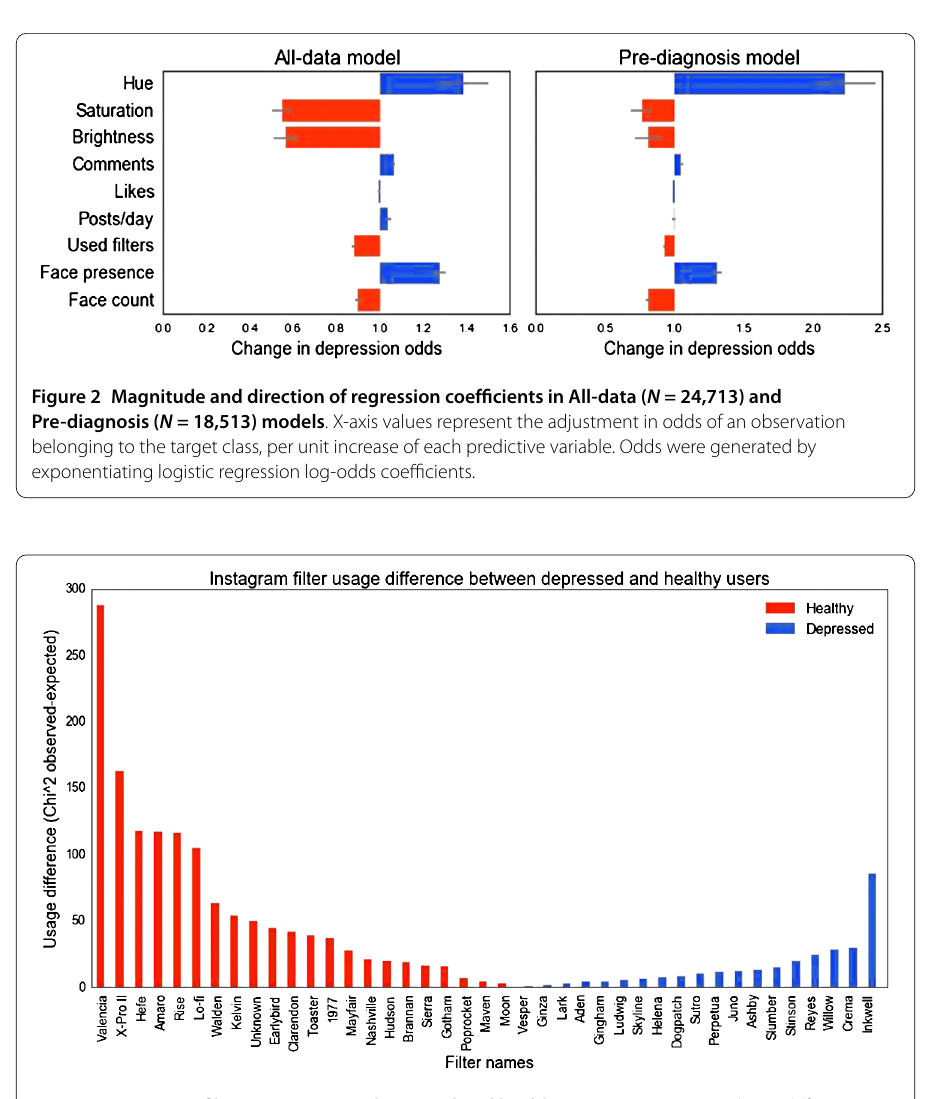
confidence, and Pre-diagnosis posting frequency dropped to % confidence, suggesting a null predictive value in the latter case. Increased hue, along with decreased brightness and saturation, predicted target class observations. This means that photos posted by depressed individuals tended to be bluer, darker, and grayer (see Figure ). The more comments Instagram posts received, the more likely they were posted by depressed participants, but the opposite was true for likes re- ceived. In the All-data model, higher posting frequency was also associated with depres- sion. Depressed participants were more likely to post photos with faces, but had a lower average face count per photograph than healthy participants. Finally, depressed partici- pants were less likely to apply Instagram filters to their posted photos. Figure  shows the magnitude and direction of regression coefficients for both